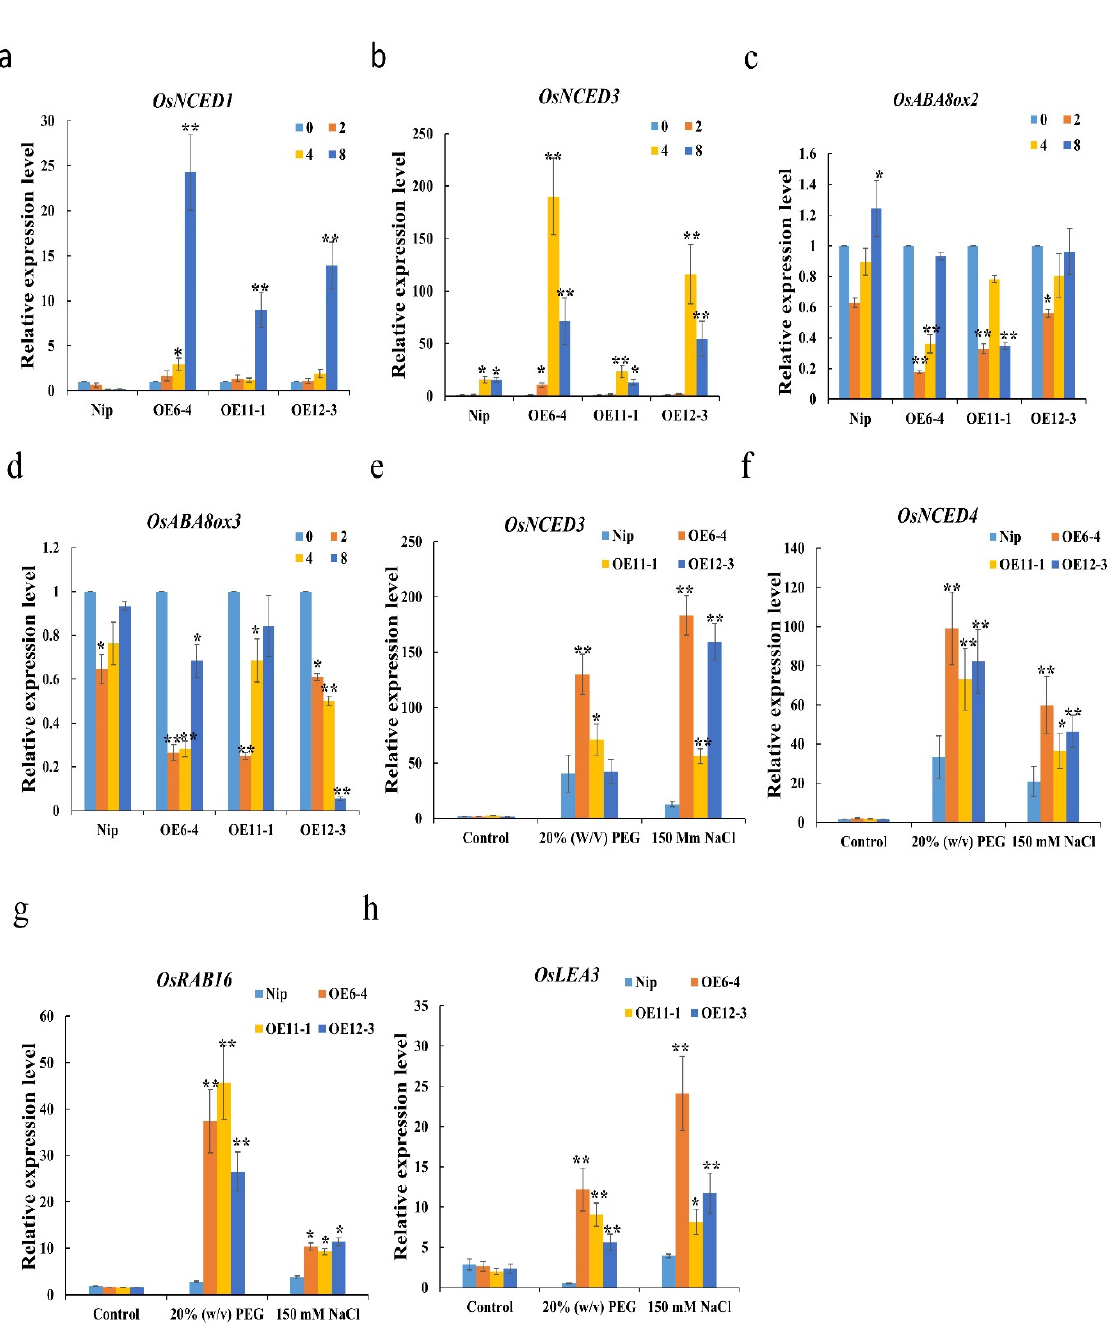
Figure 7. Expression analysis of ABA-related genes under different stress conditions. ( a – d ) The anal- ysis of the expression levels of OsNCED1, OsNCED3 , OsABA80x2, and OsABA80X3, respectively, under 50 μ M ABA treatment. ( e – h )The analysis of the expression levels of OsNCED3 , OsNCED4 , OsRAB16, and OsLEA3 , respectively, under 20% w / v PEG and 150 mM NaCl stress. Leaf samples were collected during 24h treatment. Values are mean ± SE ( n = 3). Asterisks indicate significant differences between transgenic lines and WT (* p < 0.05, ** p < 0.01). N = 20 plants per treatment.